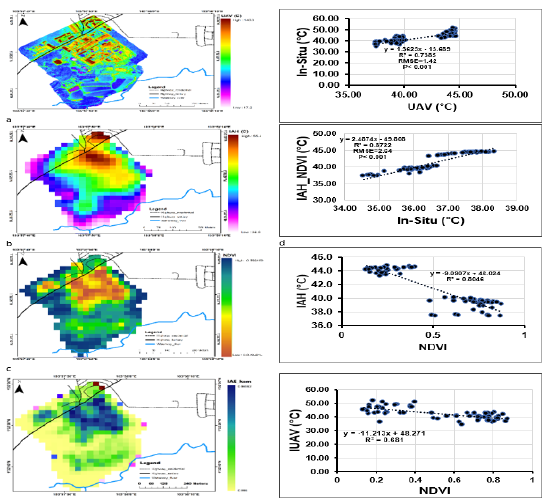
Figure 6. Statistical distribution for regression coefficient (a) for the vegetation Cover responses; and (b) Built-up cover responses taking over Keck Seng Oil Palm Industry